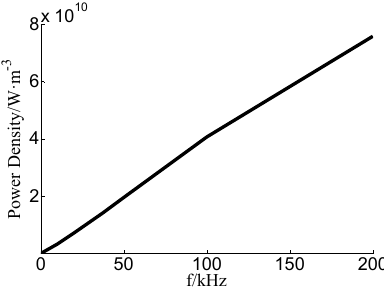
Figure 12. Power density variation with current frequency f.